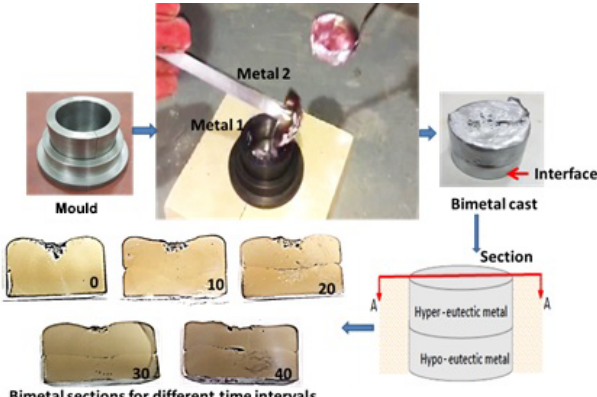
Figure 1. Schematic illustrating the layout of the mould, molten bimetal casting and sectioning of bimetal casting for different time